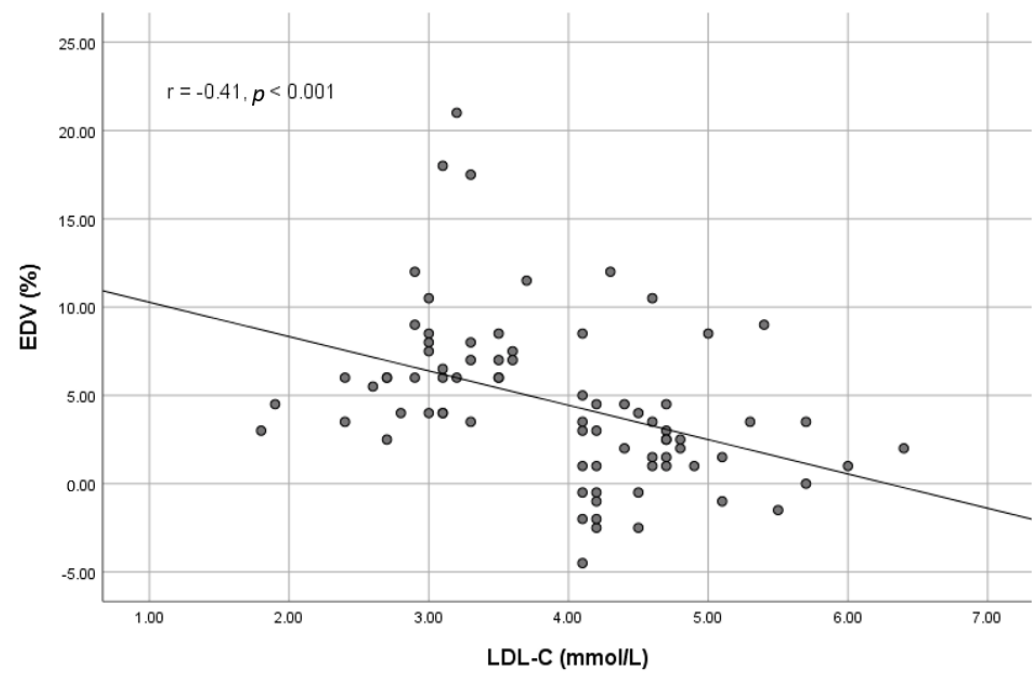
Figure 3. Correlation between endothelium-dependent vasodilation (EDV) and LDL-cholesterol.